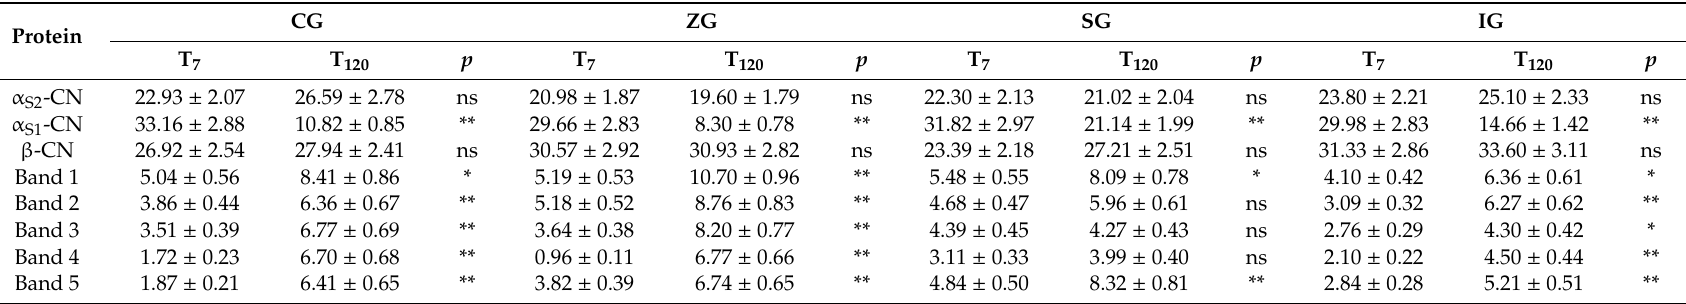
Table 3. Densitometric analysis of SDS-PAGE protein bands (Figure 3) in fresh (T 7 ) and 120-days ripened (T 120 ) cheese samples obtained from lactating dairy cows fed control diet (CG) and control diet supplemented with zinc (ZG), selenium (SG), and iodine (IG). Protein